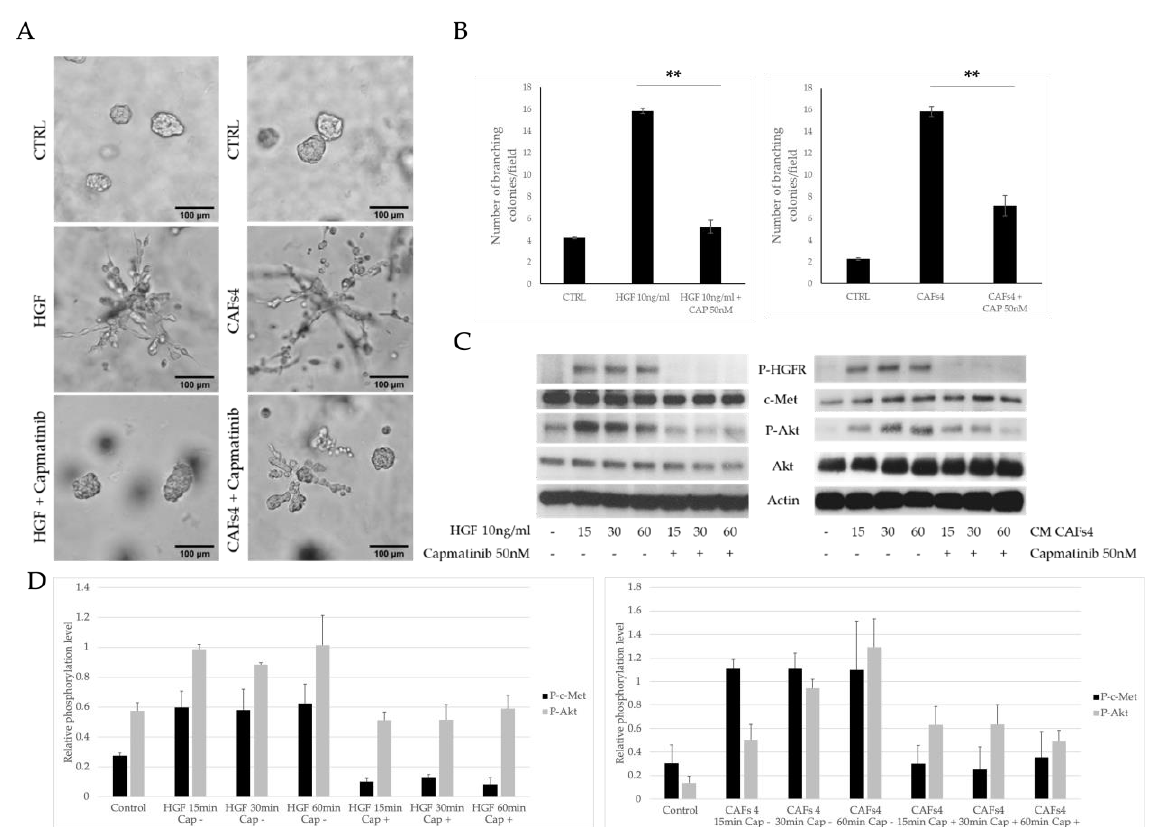
Figure 3. Analysis of c-Met pathway involvement in HGF-mediated MDA-MB-231 colony branching ( A ). Representative colony photographs of 3D matrigel cultures, HGF and HGF with capmatinib treatment on the left panel, conditioned media (CM) from ERα36 high (CAF4) culture and capmatinib treatment on the right panel, 10× magnification, capmatinib significantly inhibited colony branching induced by HGF as well as by CAF4-CM ( B ). Graphs representing data from 3D matrigel cultures, ** p < 0.005 between HGF or CAF4-conditioned media treatment and addition of capmatinib ( C ). Western blot analysis of c-Met-signaling pathway after HGF and CAF4-CM treatment at different times (15 – 60 min), with or without capmatinib treatment. Activation of c-Met receptor and Akt was inhibited after capmatinib treatment. ( D ) Densitometry measurements of protein phosphorylation as a ratio between phosphorylated to total protein signal.